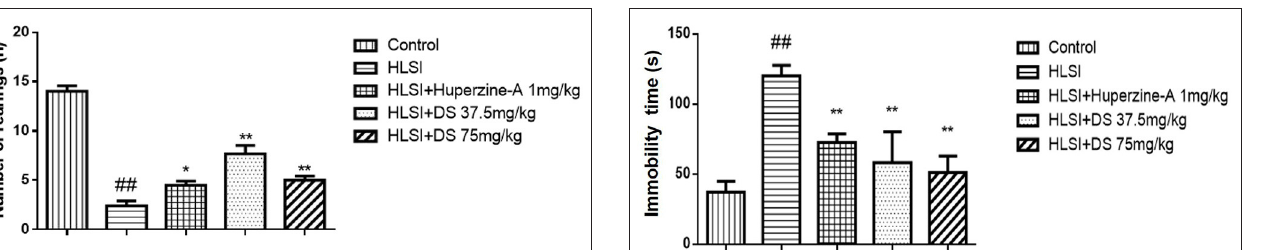
FIGURE 8 | The effects of DS on the immobility time in the forced swimming test after HLSI in rats. The values are mean ± SEM ( n = 8–9). The symbols represent: ## p < 0.01 as compared with the control group; ** p < 0.01 as compared with the HLSI